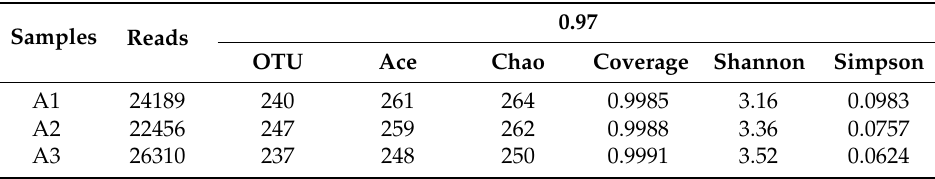
Table 3. Anammox sludge bacterial richness and diversity indices.